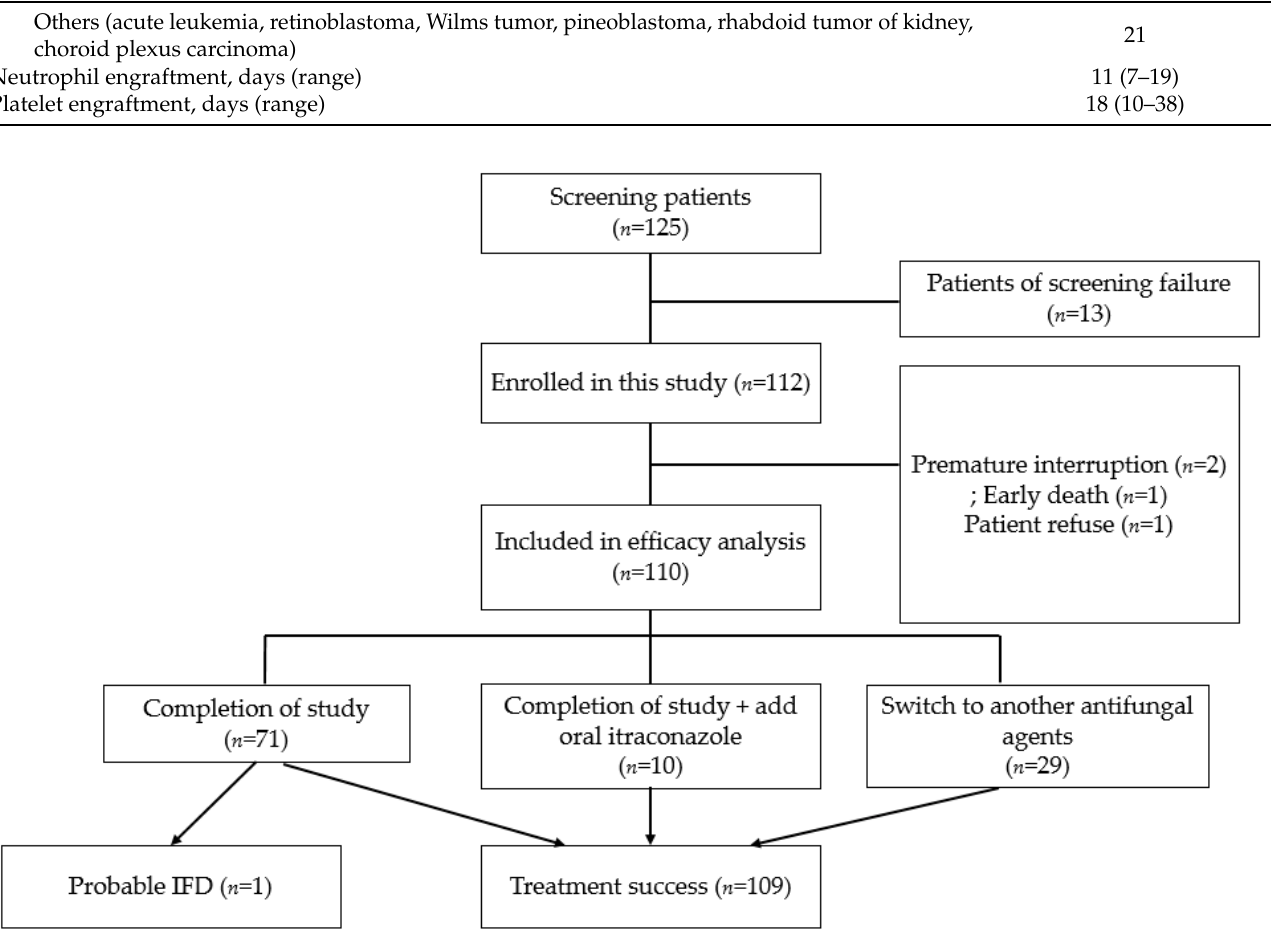
Figure 2. Flow diagram of the study. Table 1. Characteristics of the